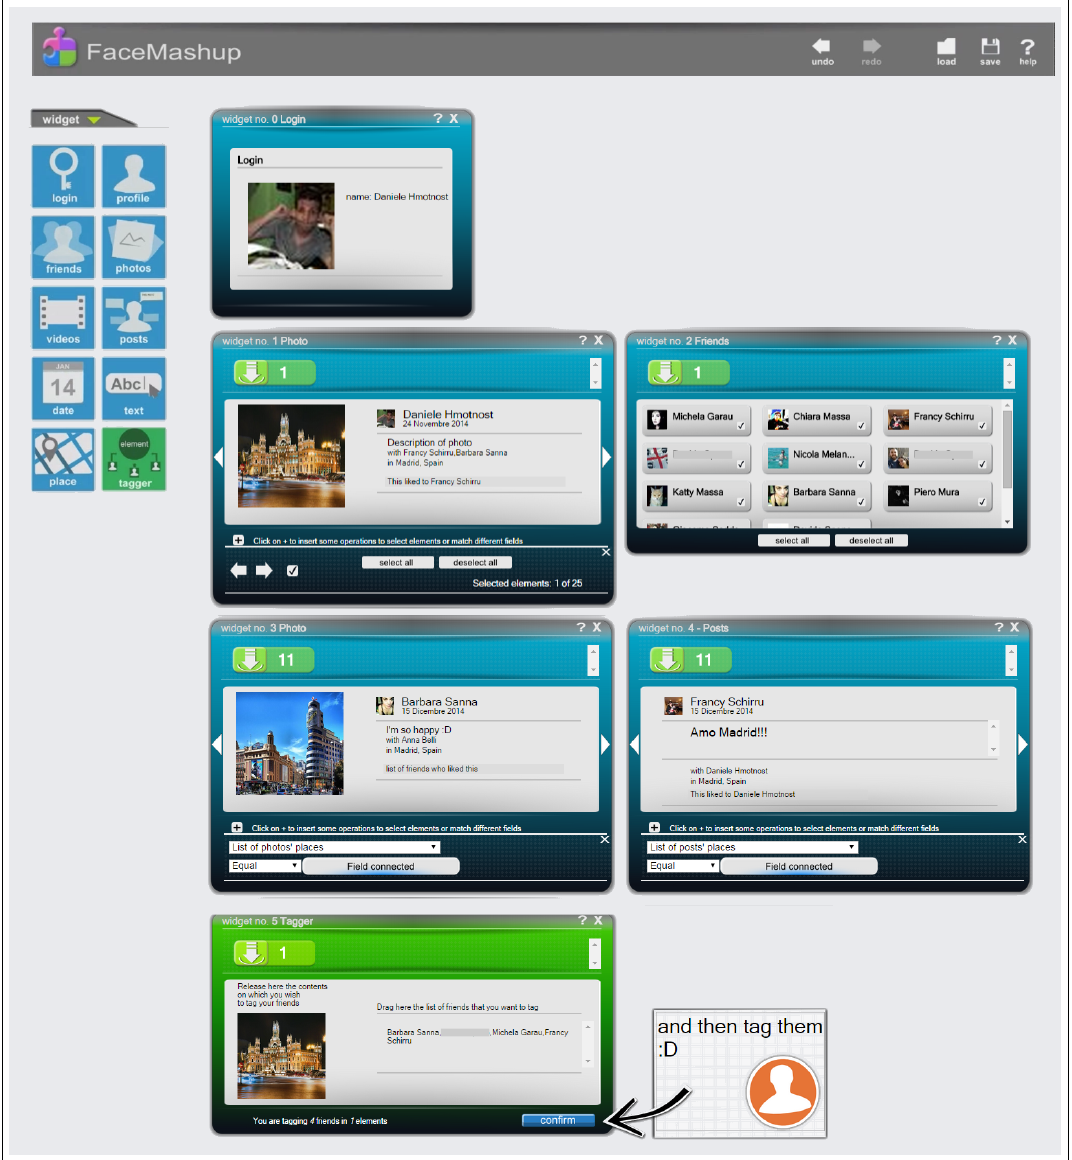
Figure 2. A sample Social Network Application developed with